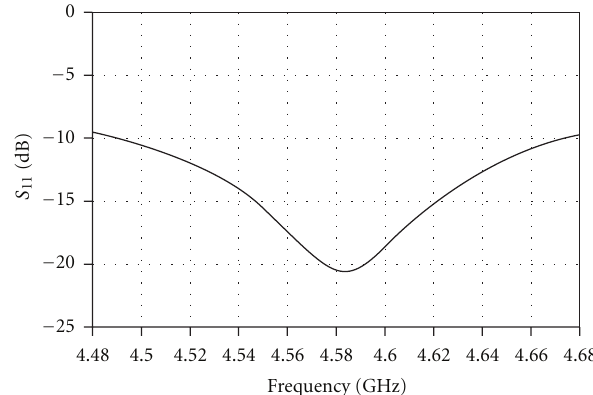
Figure 5: Measured input reflection of slot dipole over a 10 λ by 10 λ ground plane